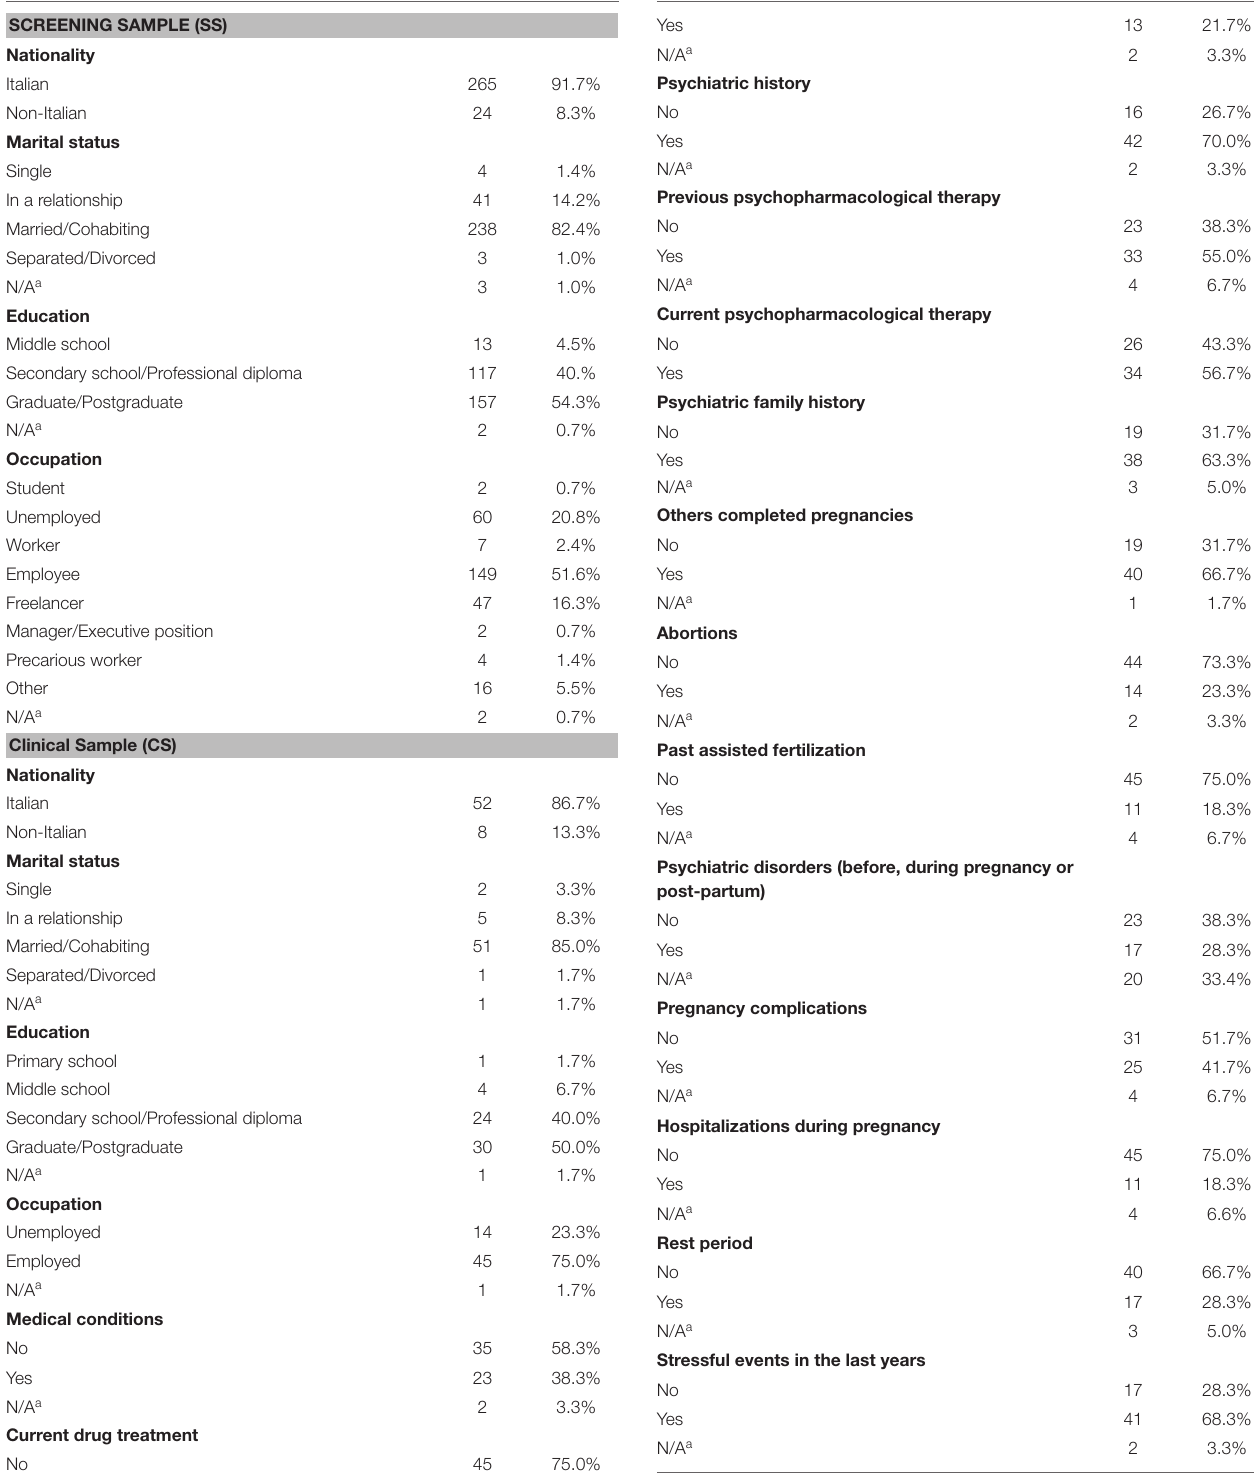
TABLE 1 | Demographic data of both samples (SS, N = 289; CS, N =